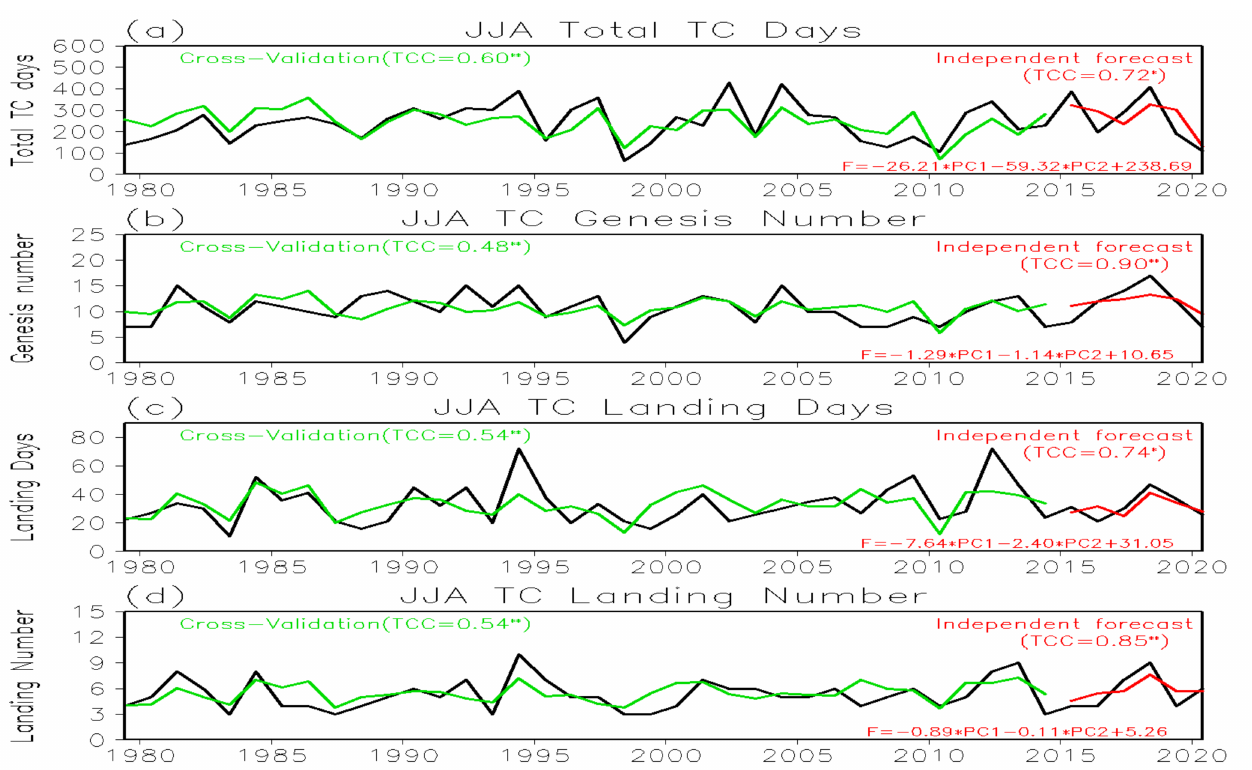
Figure 7. ( a ) The total TC days and ( b ) the total TC genesis number over the WNP and the TC days ( c ) and TC number ( d ) landing on the coast of China. Black lines are observations based on best-track data from the Tokyo-Typhoon Center. The green lines are cross-validated reforecast. The red lines are the independent forecasts for the period of 2016–2020. The time correlation confidence with * (**) are significant at the 95% (99%)